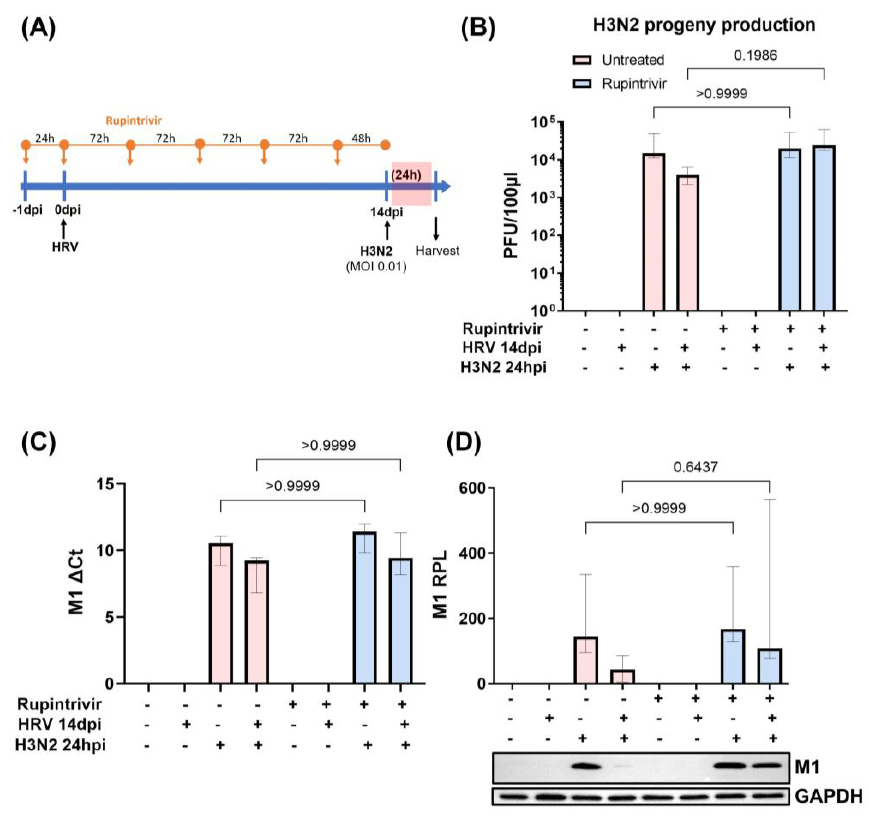
Figure 4. Earlier and longer-duration Rupintrivir-mediated inhibition of HRV 3C protease from pro- longed primary HRV infection abolished the reduction in live influenza viral load of secondary H3N2 infection. ( A ) Timeline of early and multi-dose Rupintrivir treatment prior to secondary H3N2 infection of hNECs. ( B ) Infectious virus progeny was quantified (PFU per 100 µL) using virus plaque assay ( n = 6). ( C ) The mRNA levels ( n = 4) and ( D ) relative protein levels (RPL) ( n = 6) of IAV M1 of secondary H3N2 infection, with and without Rupintrivir treatment, in infected and mock control hNECs. Representative Western blot images are shown. The relevant band intensities were measured using ImageJ software. Protein levels were normalized to GAPDH housekeeping protein.